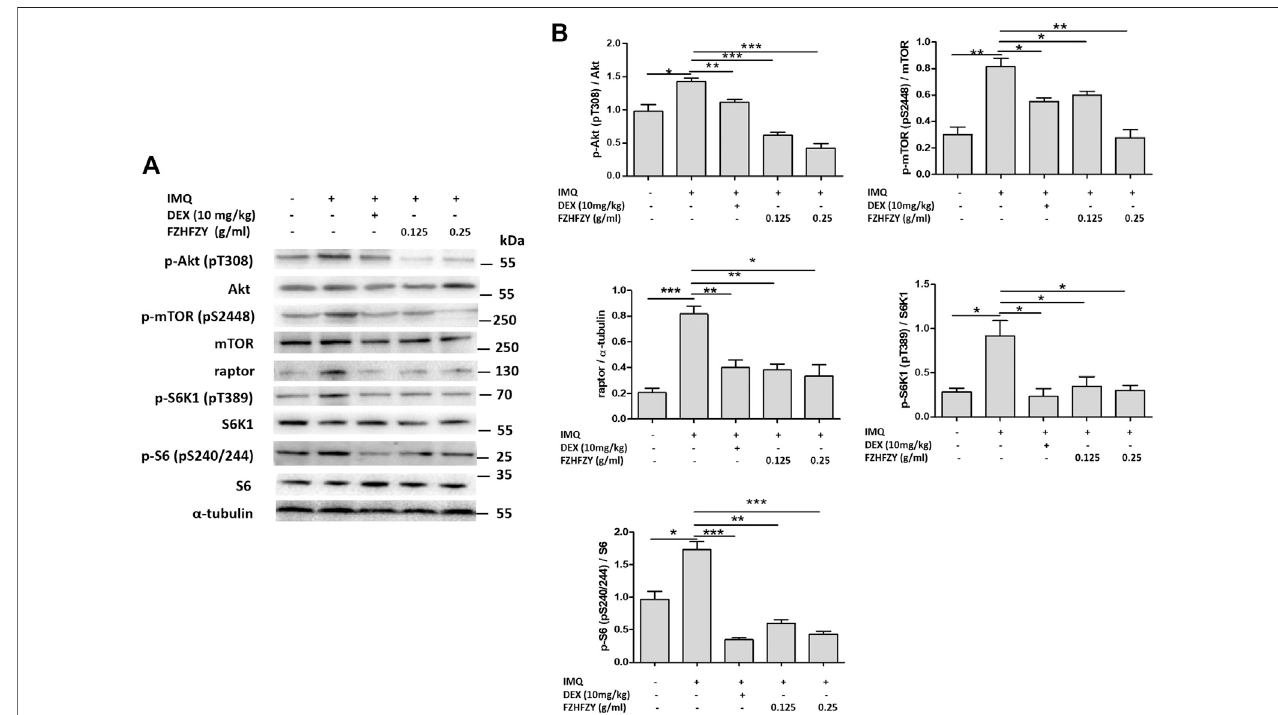
FIGURE5| EffectsofFZHFZYontheAkt/mTORC1/S6K1signallingpathwayinmicewithIMQ-inducedpsoriasis. (A) RepresentativewesternblotofAkt/mTORC1/ S6K1pathwayproteinexpressionintheskinofmicewithIMQ-inducedpsoriasis. (B) Quanti fi cationoftheamountsofphospho-Akt,phosphor-mTOR,phosphor-S6K1, phosphor-S6 and raptor relative to those of Akt, mTOR, S6K1, S6 and α -tubulin in the skin of mice (* p < 0.05, ** p < 0.01, *** p < 0.001 vs . IMQ-induced psoriasis group; n (cid:2) 6).